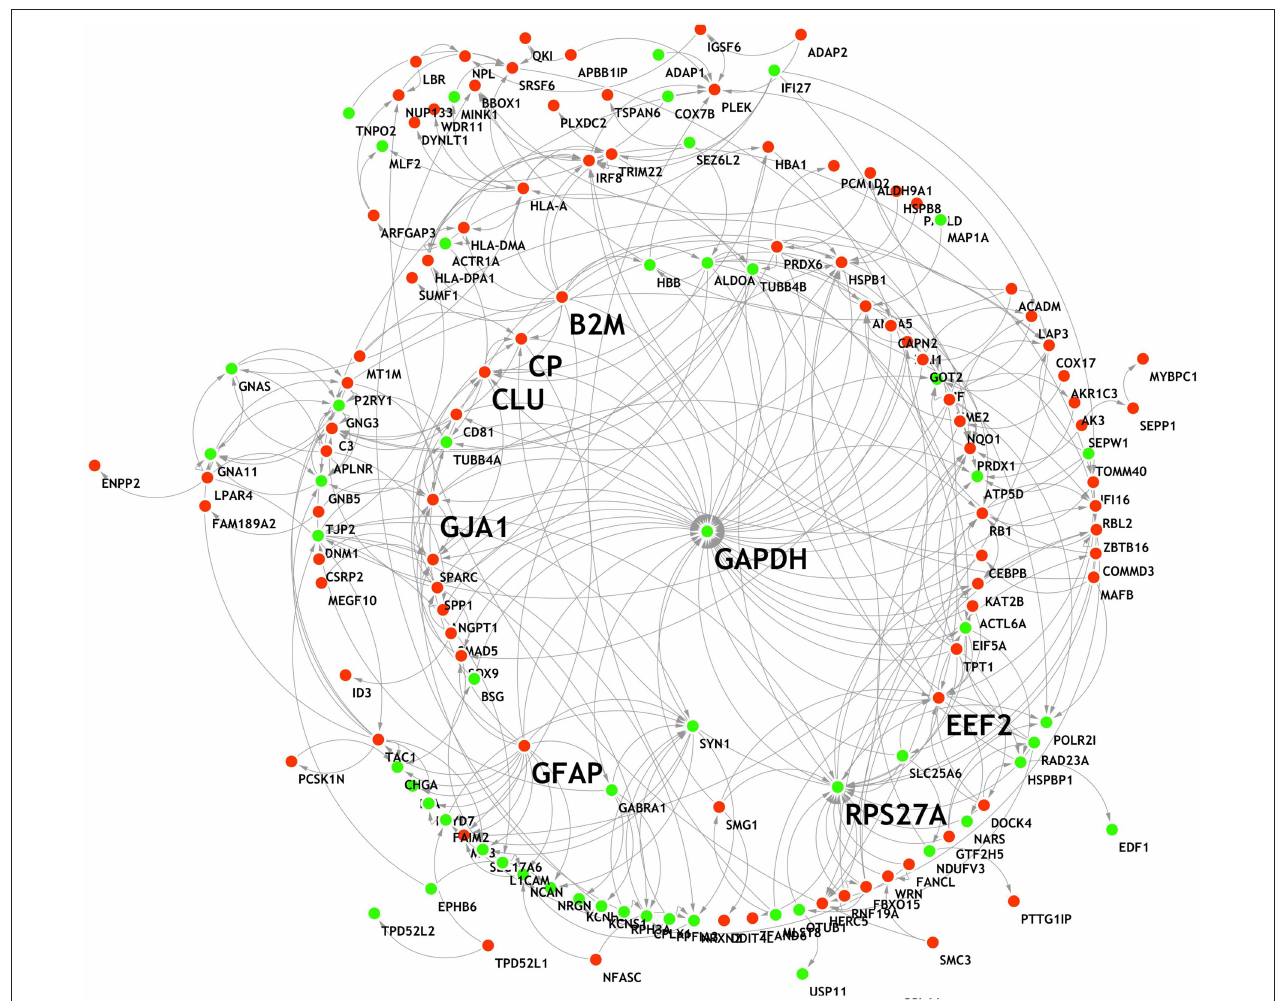
FIGURE 5 | PPI network of the DEGs. Red, up-regulation; green,